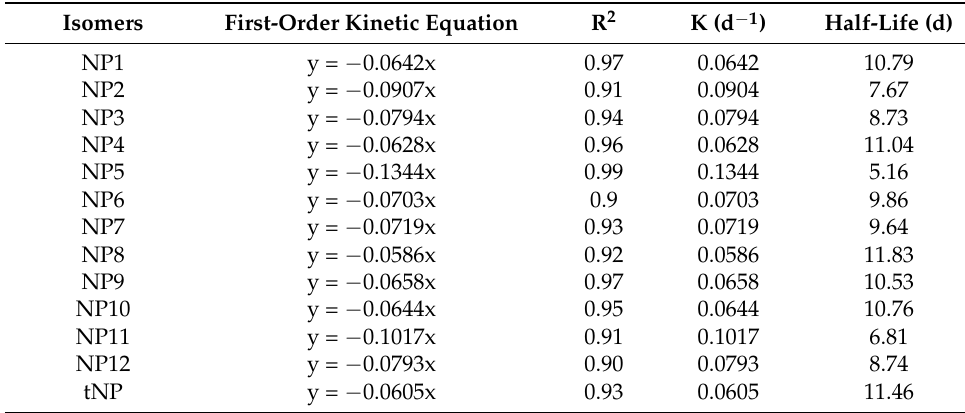
Table 2. NP degradation kinetic equations of 12 isomers in FN soil.